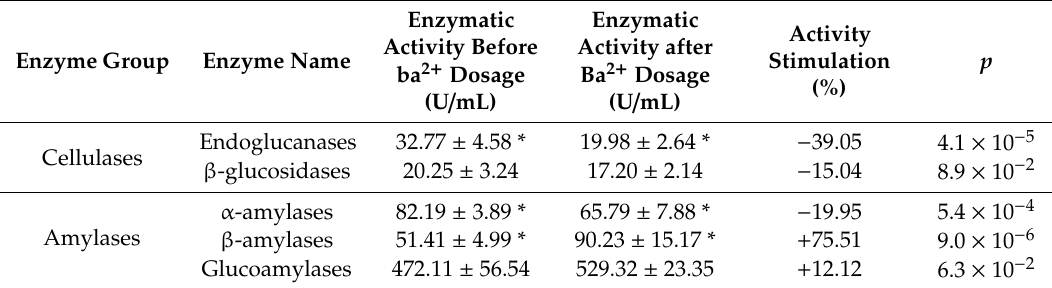
Figure 3. Effect of Ba 2+ dosage over enzymatic activities and sCOD in the ASHR, error bars indicate standard deviation of three replicates, the dotted vertical line indicates the beginning of barium dosage ( A .—Outlet sCOD in the ASHR in steady-state, B .—Activity results for the five studied enzymes, C .—Close up on the activity results with lower values). Table 7. Activity values and significance for the different studied enzyme groups .